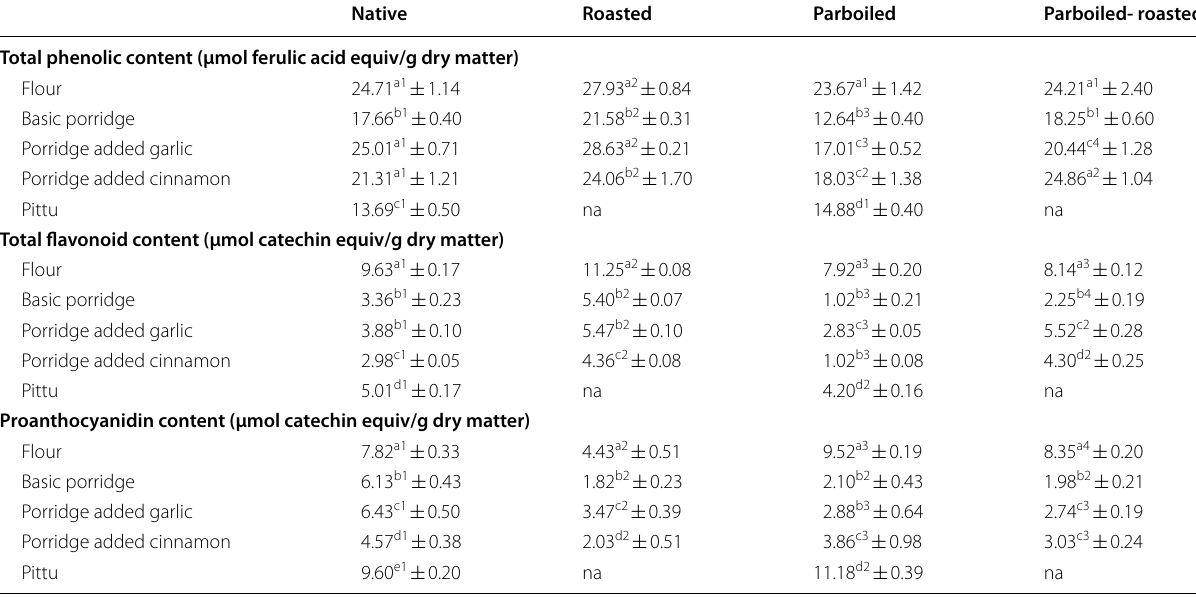
Table 2 Total phenolic, total flavonoid and proanthocyanidins contents of finger millet flour, and food subjected to different processing